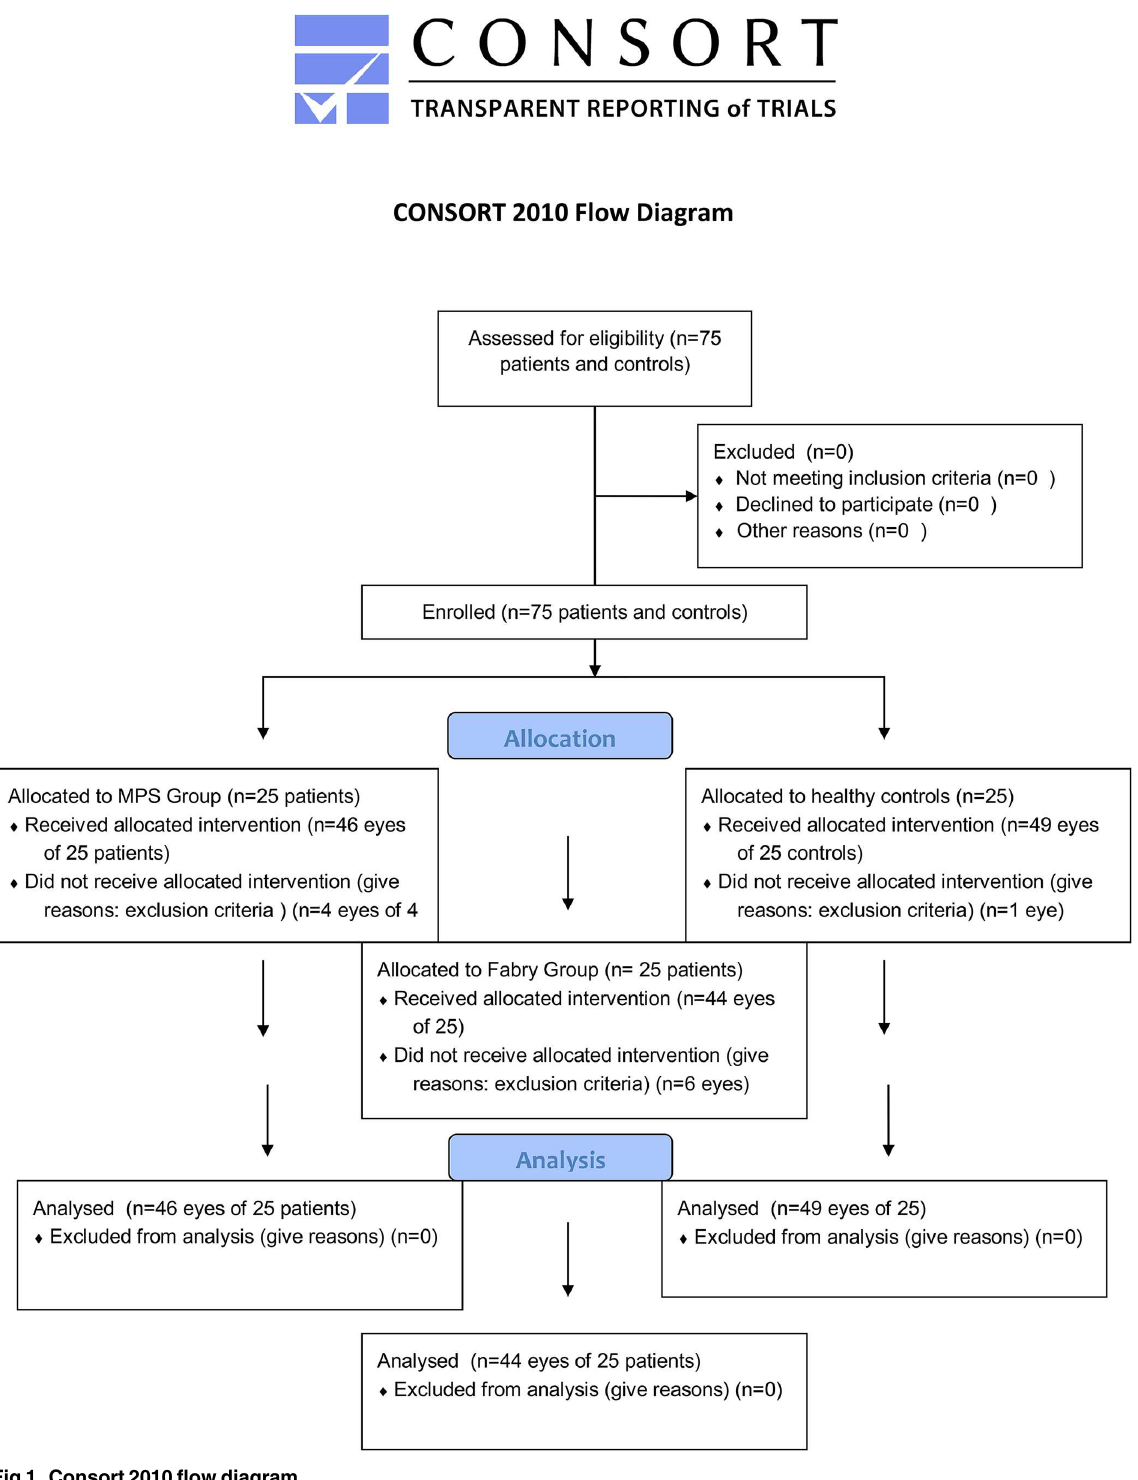
Fig 1. Consort 2010 flow diagram.